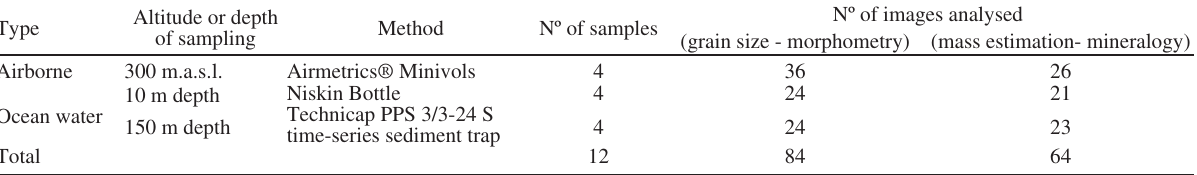
Table 1. – Samples